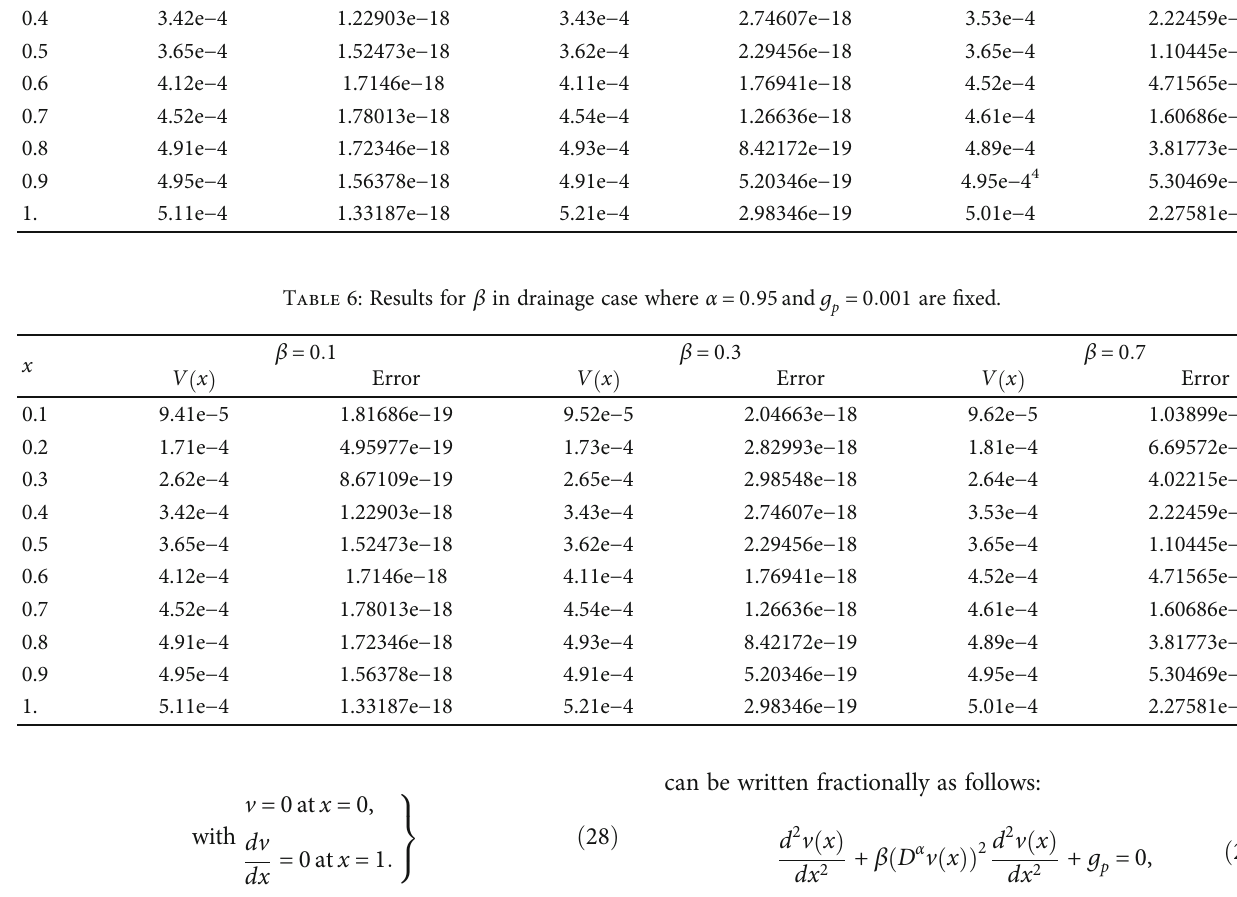
Table 5: Results for g in drainage case where α = 0 : 99and β = 0 : 1 are fi xed. p